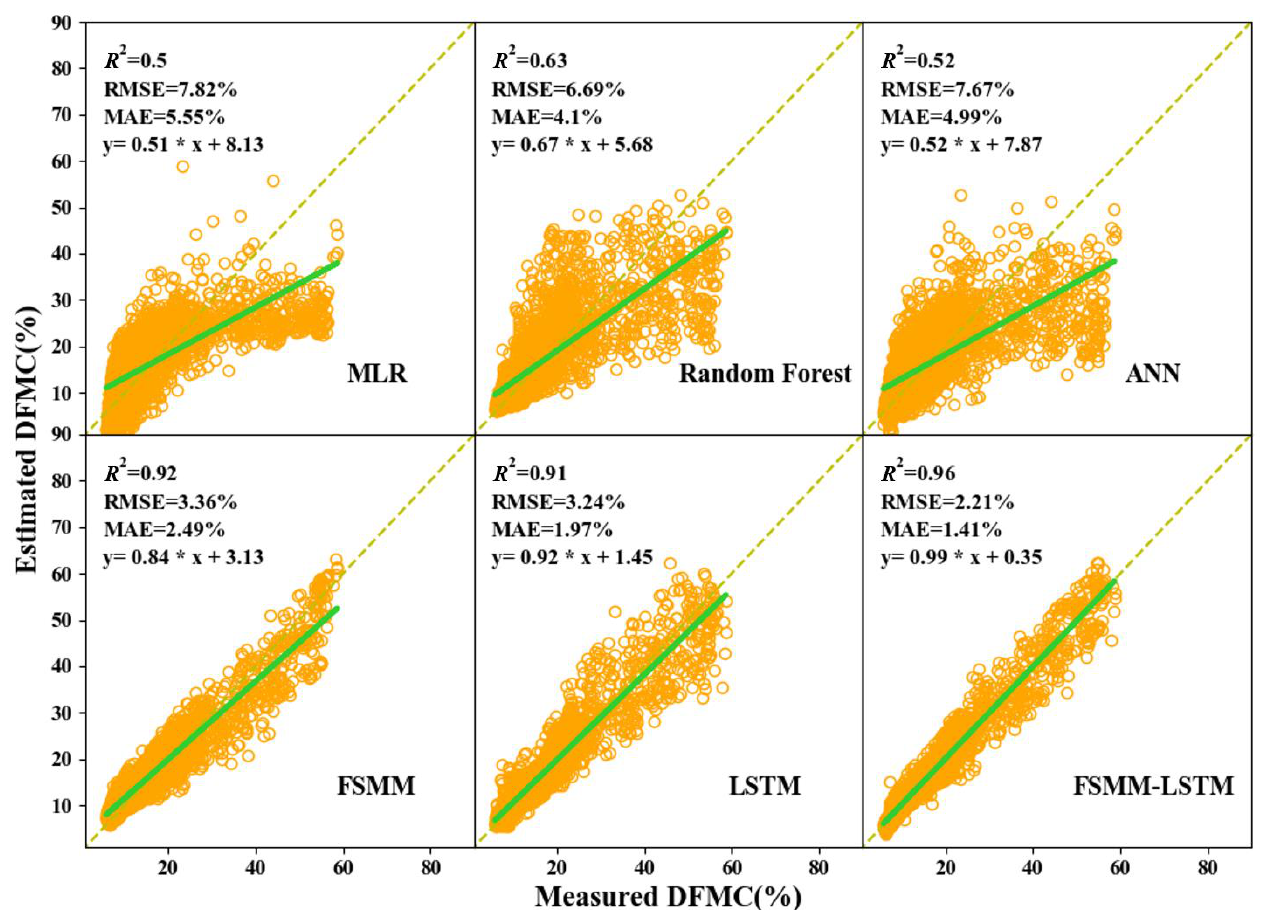
Figure 6. Performances of all models, including MLR, Random Forest, ANN, FSMM, LSTM, FSMM-LSTM.